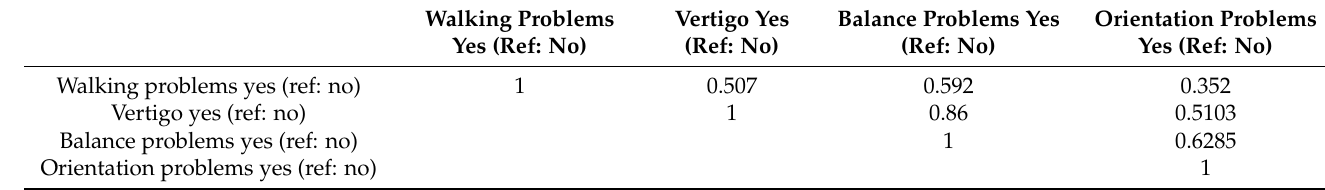
Table 5. Tetrachoric correlation matrix of the four “significant